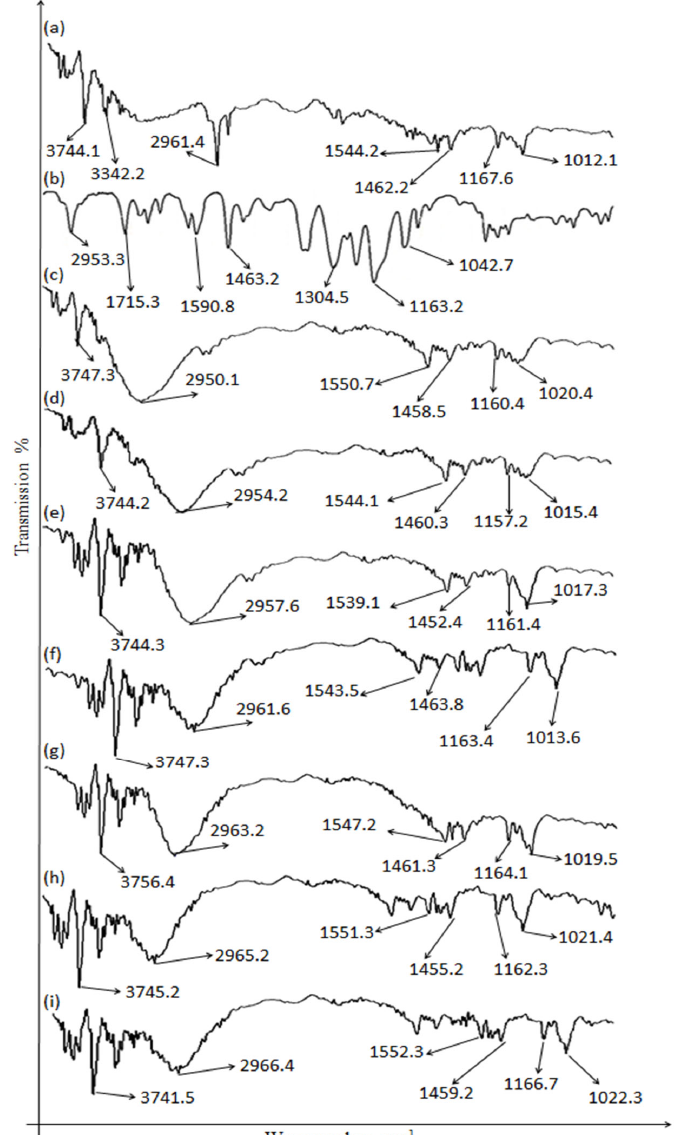
Figure 1. FTIR spectra of ( a ) clarithromycin, ( b ) pantoprazole sodium, ( c ) F1, ( d ) F2, ( e ) F3, ( f ) F4, ( g ) F5, ( h ) F6, and ( i ) F7.